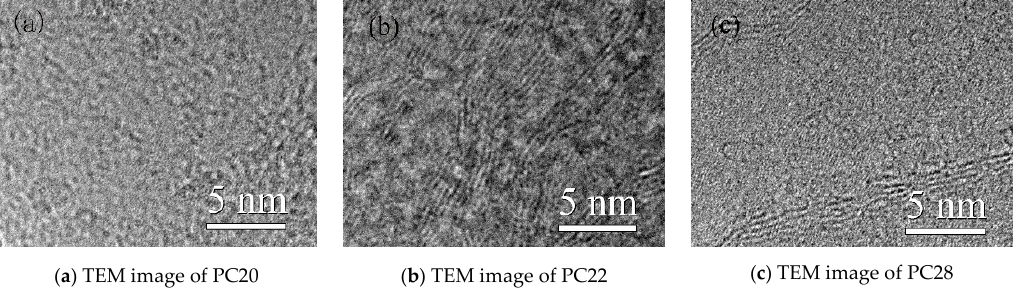
Figure 4. Transmission electron microscopy (TEM) microstructure analysis of petroleum coke under different temperatures. ( a ) TEM image of PC20; ( b ) TEM image of PC22; ( c ) TEM image of PC28.